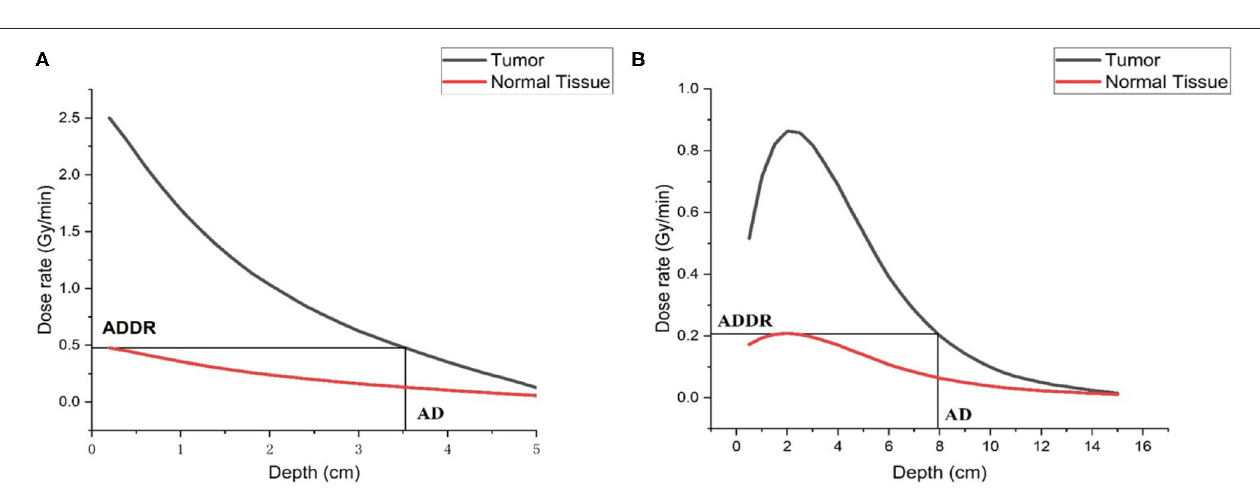
FIGURE 9 | Dose distribution in the phantom, (A) is thermal neutron beam, and (B) is epithermal neutron beam.